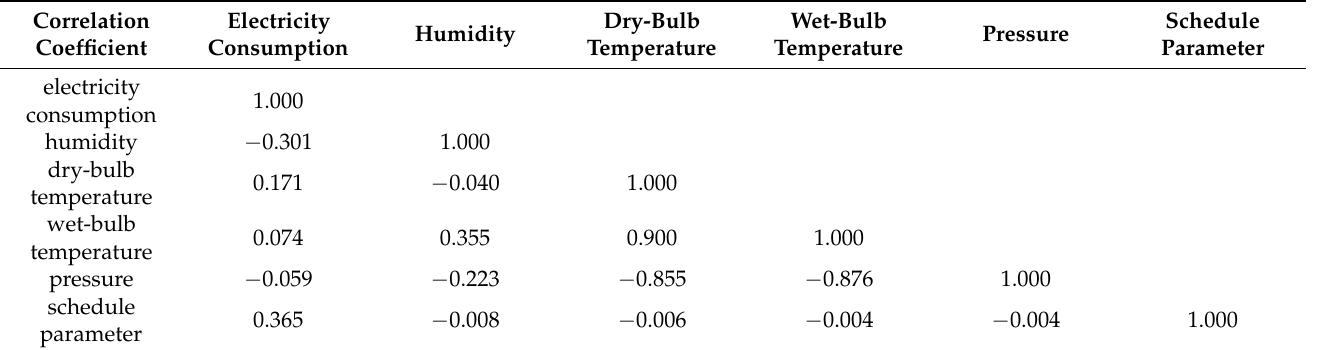
Table 1. The correlation between the auxiliary parameters and the power consumption